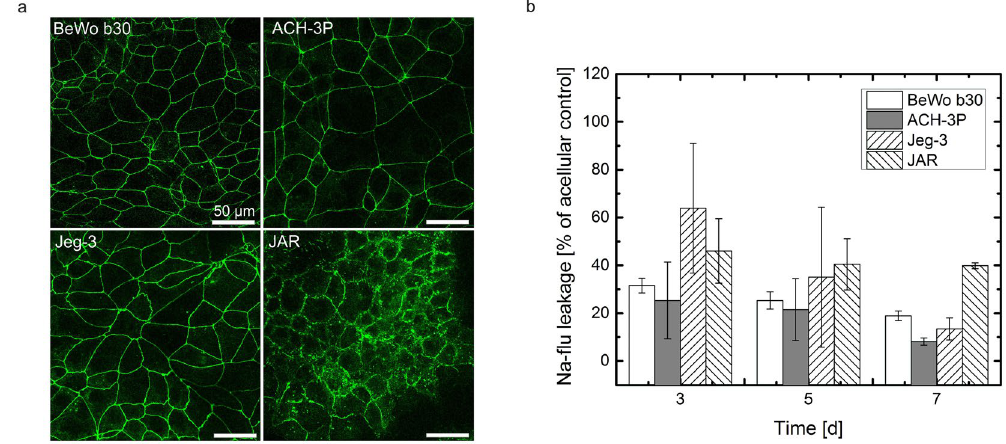
Figure 1. Barrier integrity of trophoblast cell lines. ( a ) Confocal laser scanning micrographs of tight junctions of BeWo, ACH-3P, Jeg-3 and JAR placental cell lines grown on gelatin-coated cover slides day 3 post seeding. Tight junctions are visualized using anti ZO-1 immunohistochemistry, scale bar is 50 µ m. ( b ) Leakage of sodium fluorescein through BeWo, ACH-3P, Jeg-3 and JAR placental cell barriers on day 3, 5 and 7 post seeding. Data points are presented as mean values ± SD for n = 3 and expressed as % of acellular controls.